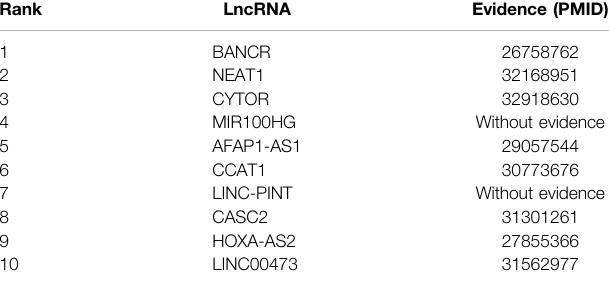
TABLE 6 | Case study results of liver cancer.